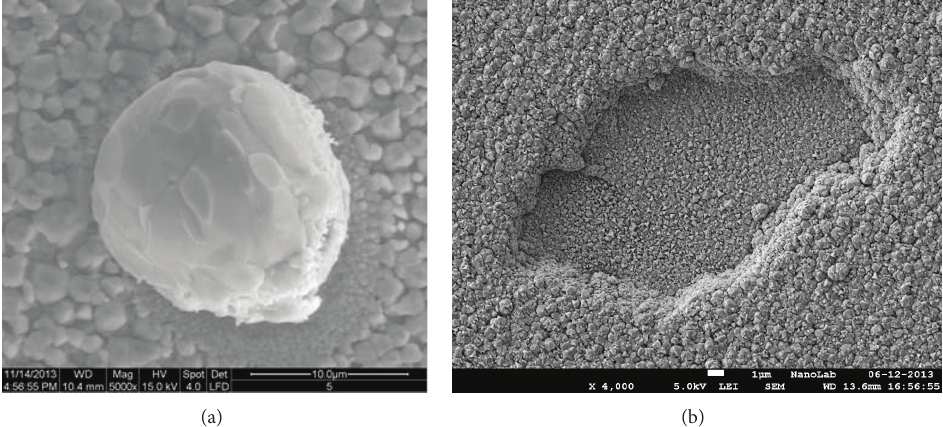
Figure 5: Secondary-electron SEM images of shunt-causing defects. (a) Following CIGS deposition, numerous CuSe within crater-like defects. (b) Following ZnO:Al/i-ZnO/CdS deposition, the CuSe